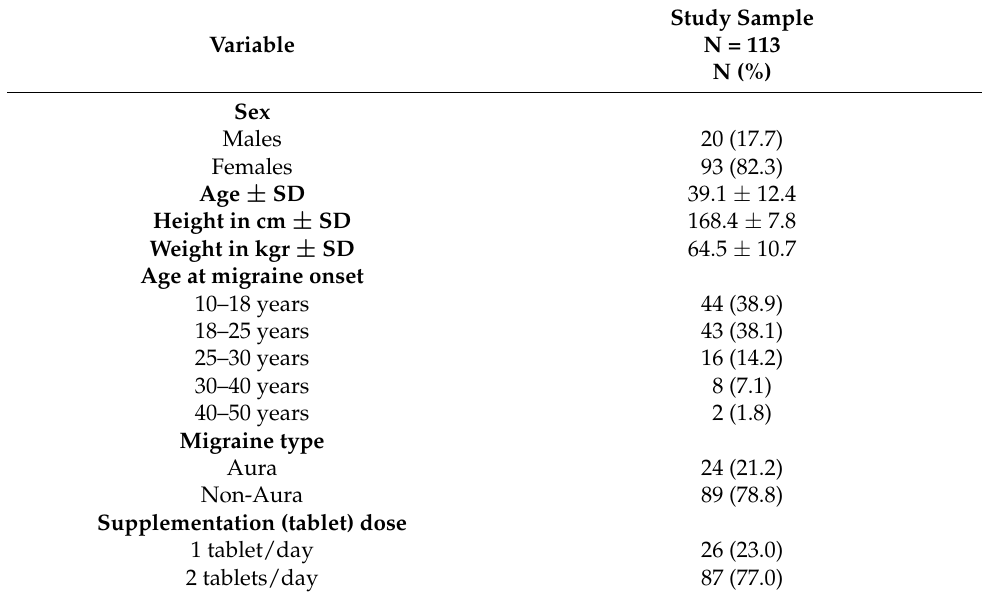
Table 1. Patients’ baseline and clinical